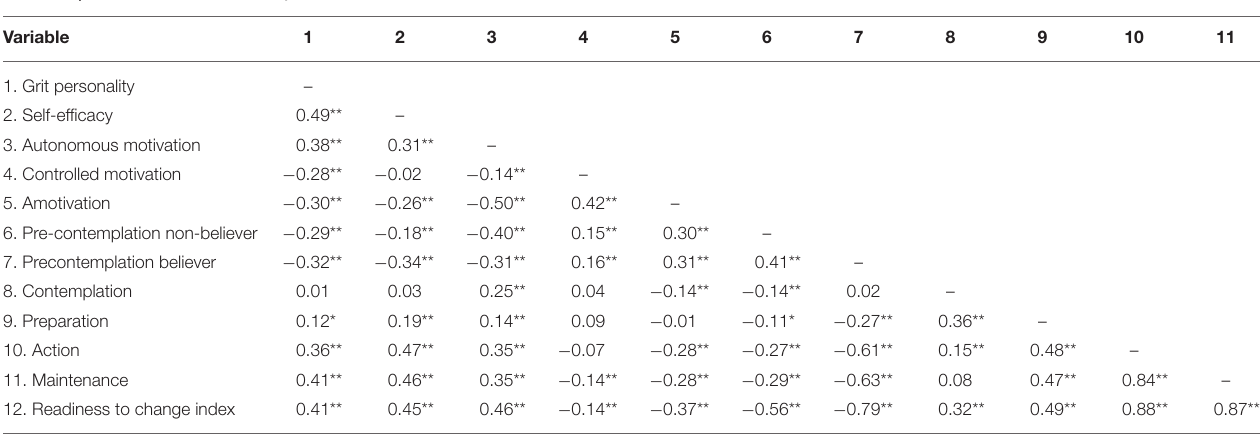
TABLE 2 | Correlations between study variables.